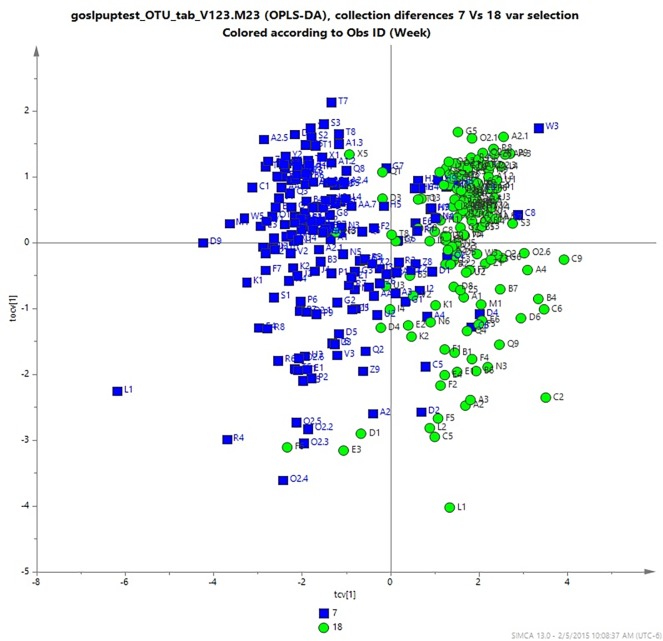
An OPLS-DA revealed differences in composition of the microbiota of dogs related to age.The OPLS-DA plot shows a comparison of the fecal microbiota in 7 weeks old puppies (blue) and when they becomes 15–18 months old (green), OPLS-DA; Q2 = 0.61.